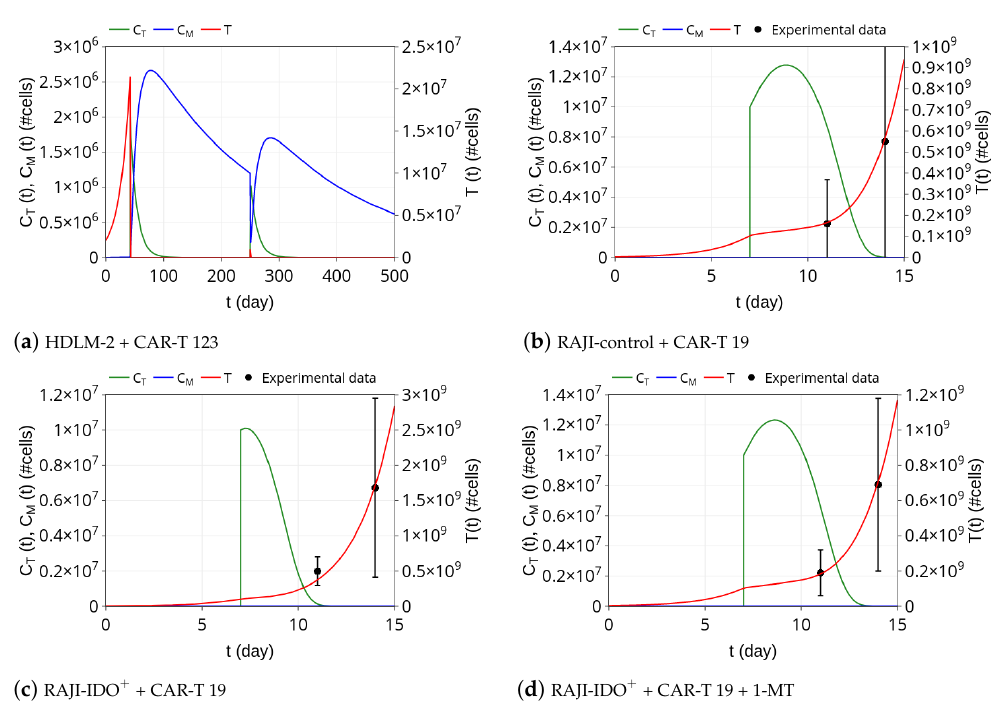
Figure 3. Dynamics of tumor cells T (red), effector C T (green), and memory C M (blue) CAR-T cell populations (#cells stands for number of cells). ( a ) The immunotherapy with CAR-T 123 on HDLM-2 and challenge were performed at t = 42 and t = 250 days, respectively. After effector CAR-T cell injection, tumor cells were rapidly eliminated and a decay of effector CAR-T cells is observed,